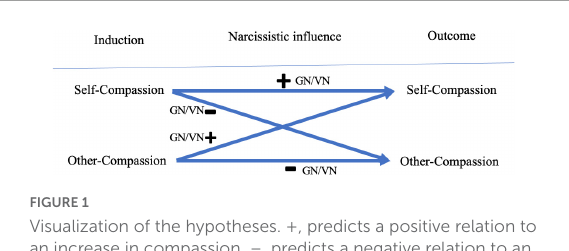
FIGURE1 Visualization of the hypotheses. +, predicts a positive relation to an increase in compassion. –, predicts a negative relation to an increase in